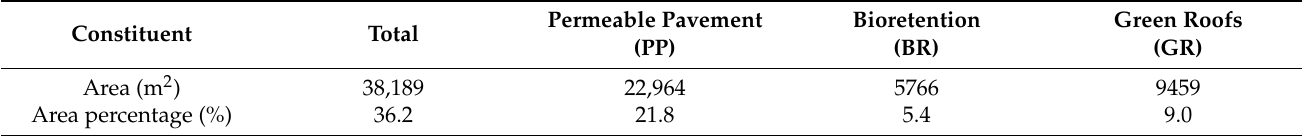
Table 12. LID types and applied areas.